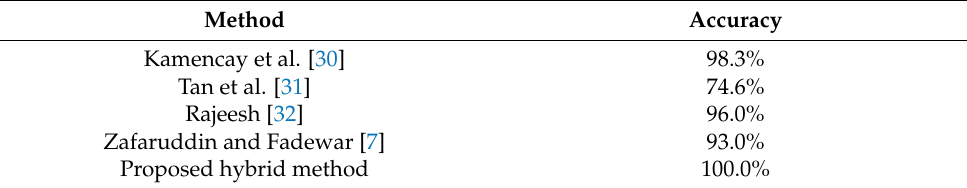
Table 7. Accuracy Analysis based on the OLR dataset.